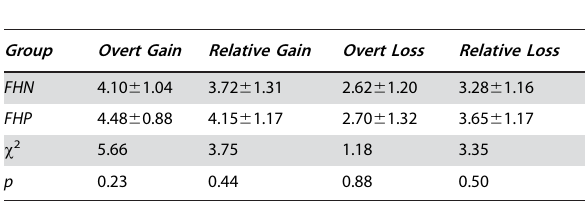
Table 2. Subject Debriefing after Domino